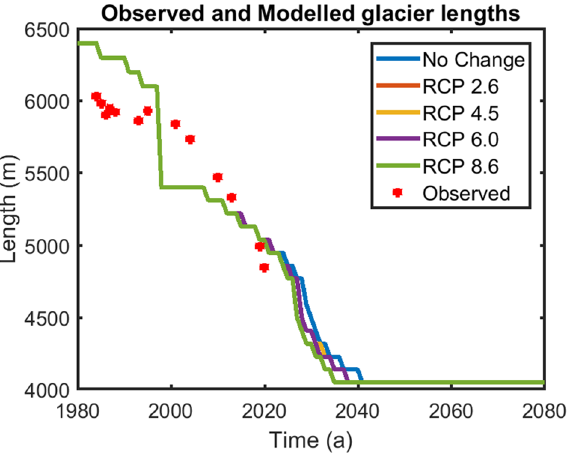
Figure 6. Future glacier length fluctuations of the Gepangath glacier under RCP 2.6, RCP 4.5, RCP 6.0 and RCP 8.6 scenarios. (URL: www. mathw orks. com).